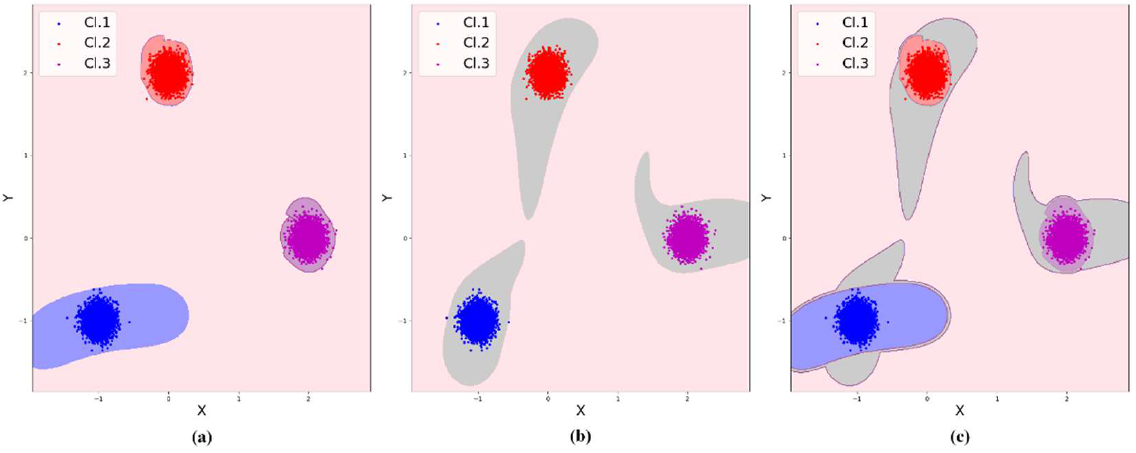
Figure 6. Feature space separation after training an ensemble of auto-encoders: specific class auto- encoders AE ( i ) ( a ), all classes auto-encoder AE 0 ( b ), combined effect of all auto-encoders ( c ).